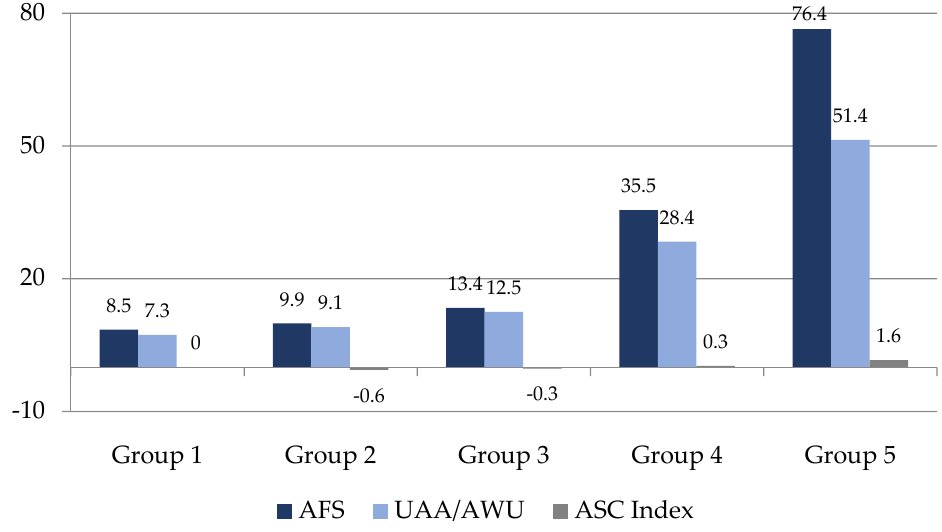
Figure 1. Mean by quintile. Source: the authors’ calculations. Note: AFS is expressed in hectares per holding; UAA/AWU is Utilised Agricultural Area by Annual Work Unit (resource structure as a land/labour relationship; ASC is an index.